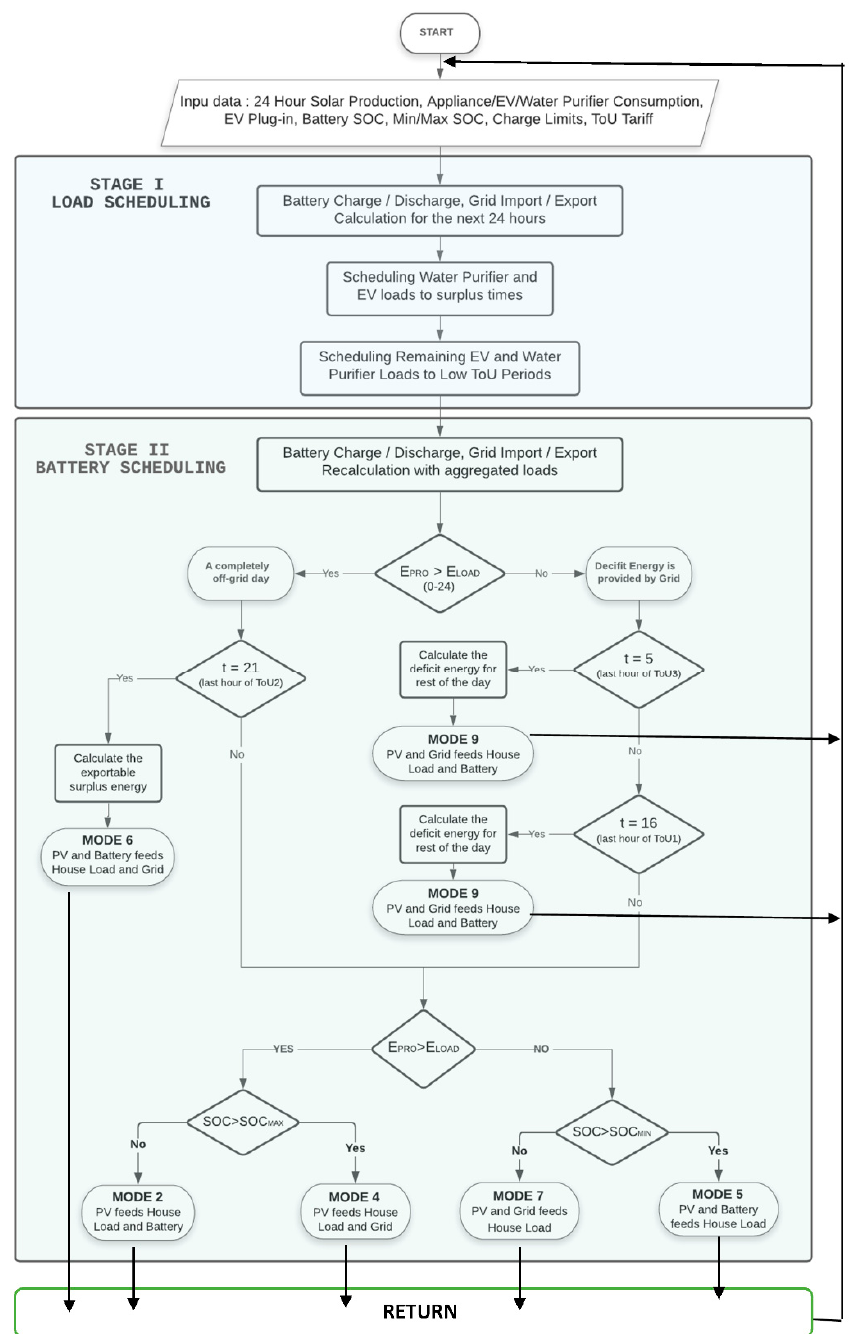
Figure 6. Flowchart of the proposed algorithm (RETURN).